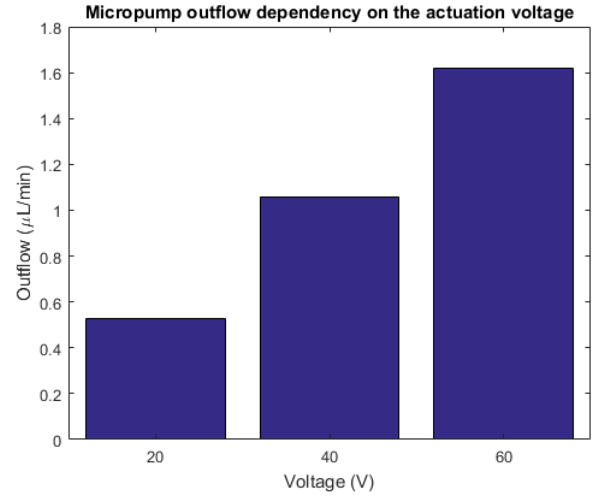
Figure 7. The outflow dependency on the actuation